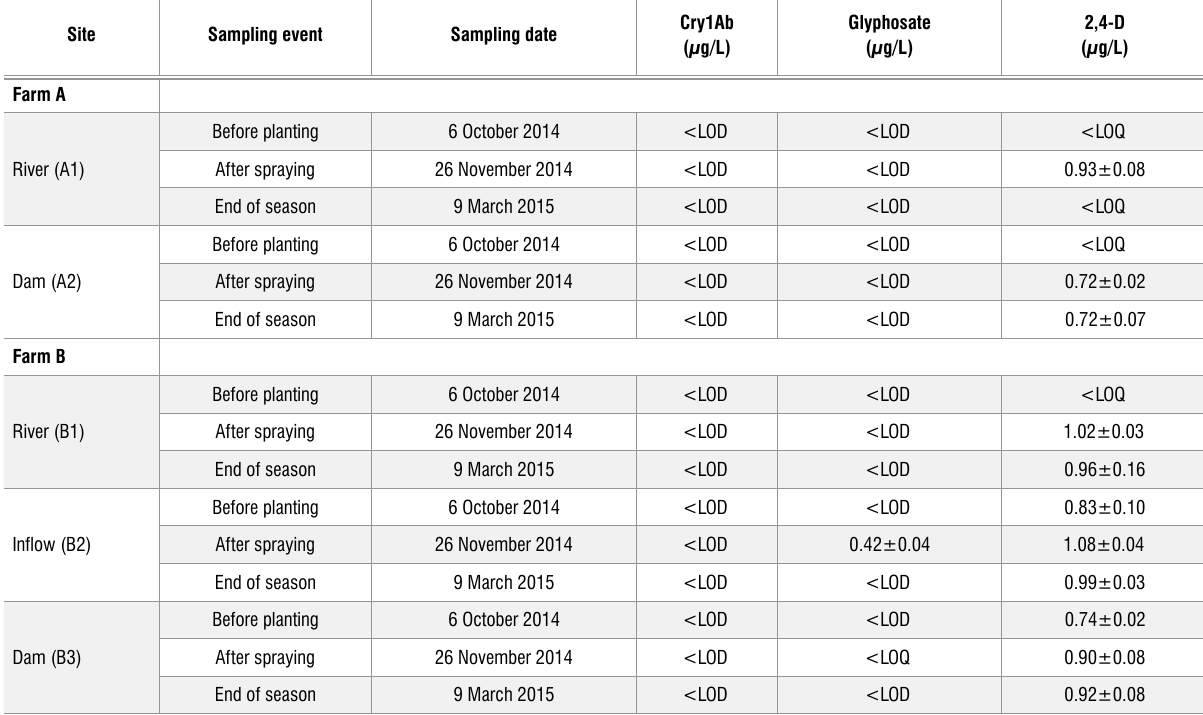
Table 1: Concentrations of the target compounds from various water sources after three different sampling events